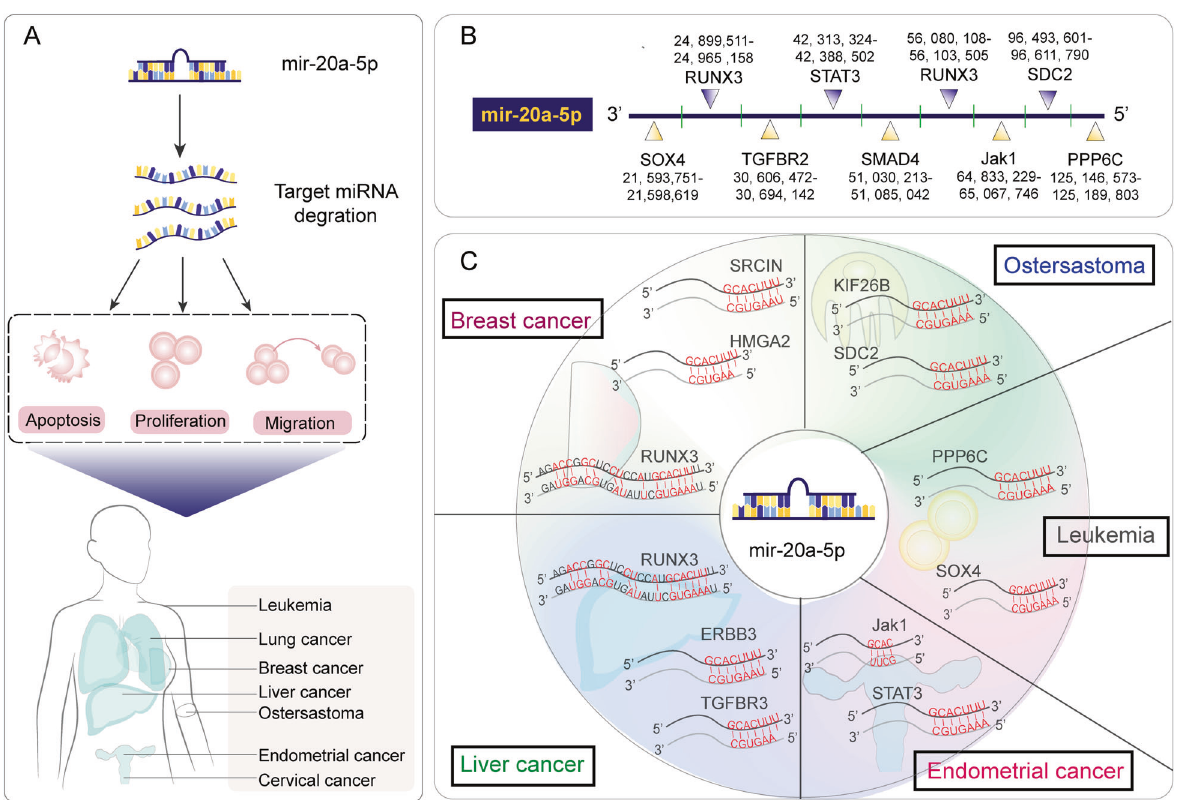
Fig. 2 miR-20a-5p expression regulations in cancers. A During the development of cancer, the expression level of miR-20a-5p changes, which promotes apoptosis, proliferation and migration of cancer cells, and ultimately leads to the development of various human cancers.